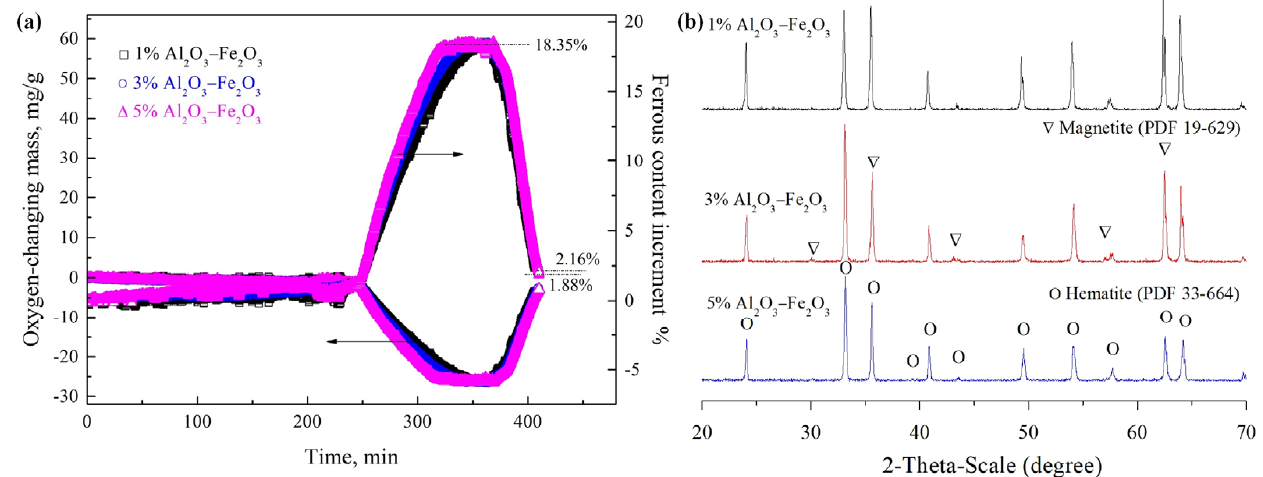
Figure 8. Effect of Al 2 O 3 content on the ferrous content in temperature-changing process from Stage 4 to Stage 9 ( a ) and XRD patterns of samples at Stage 9 ( b